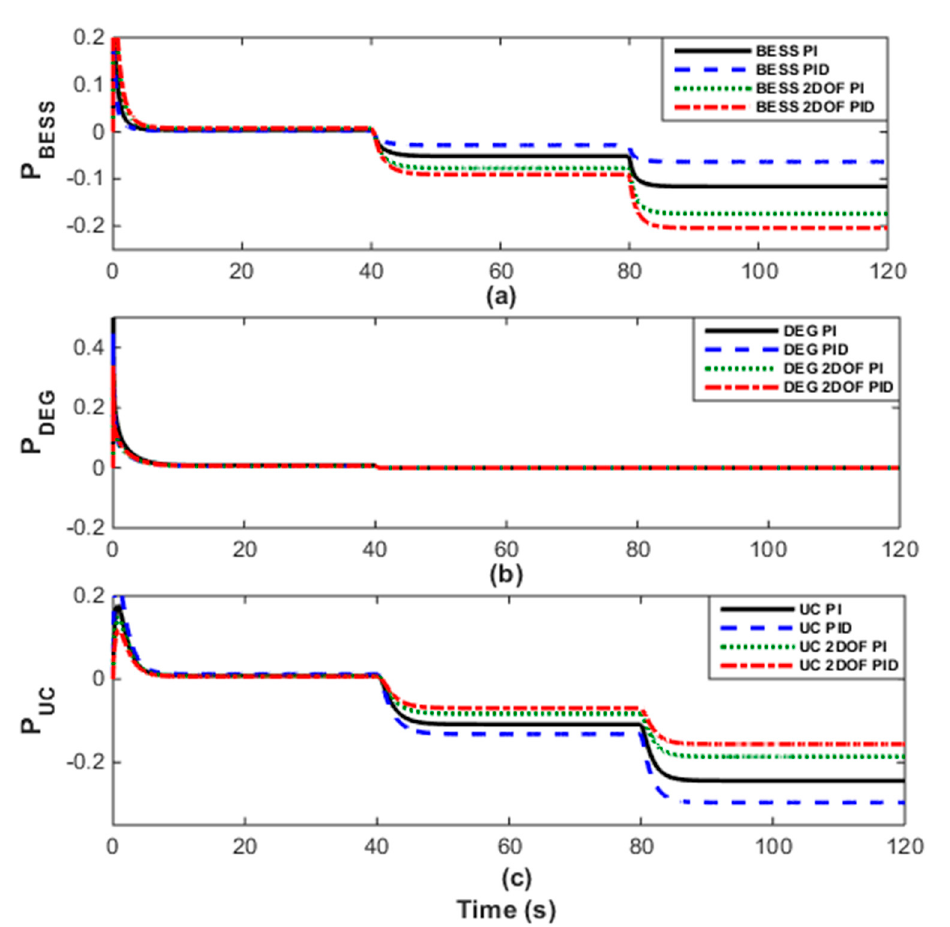
Figure 7. Output power of the ( a ) BESS, ( b ) DEG, and ( c ) UC in case2.